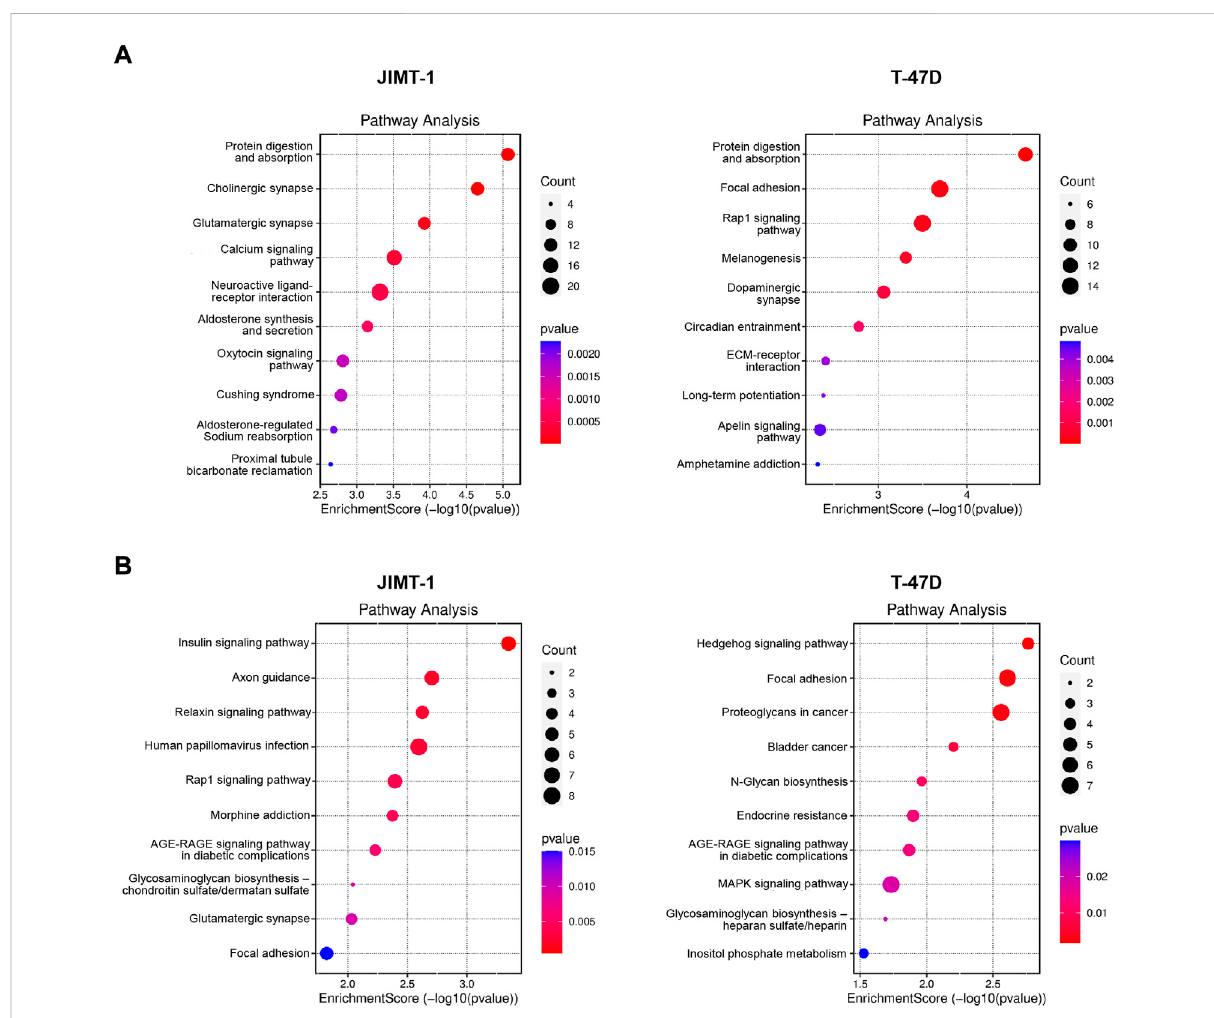
FIGURE 6 Pathwayanalysisfor (A) signi fi cantlyhypomethylated/up-regulatedand (B) hypermethylated/down-regulatedgenesinJIMT-1andT-47Dcells,